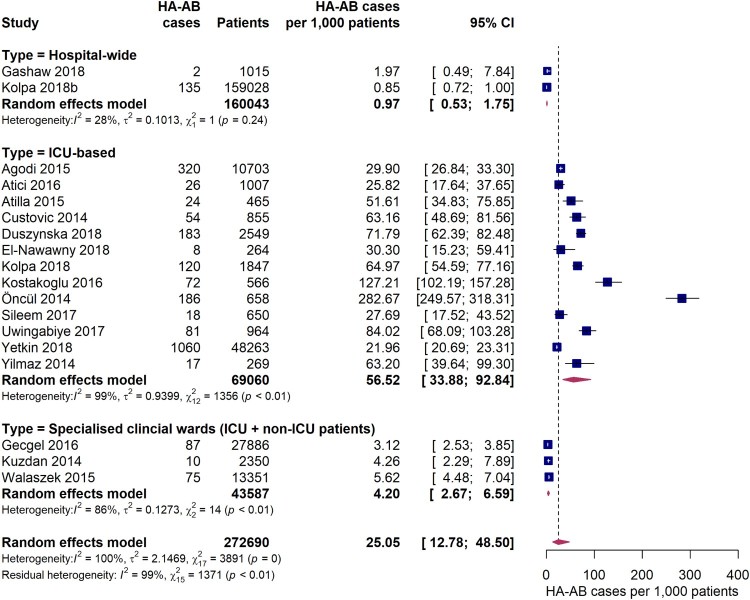
Forest plot of studies on the incidence of hospital-acquired Acinetobacter baumannii infections. Abbreviations: HA-AB: hospital-acquired Acinetobacter baumannii, ICU: intensive care unit, 95% CI: 95% confidence interval.